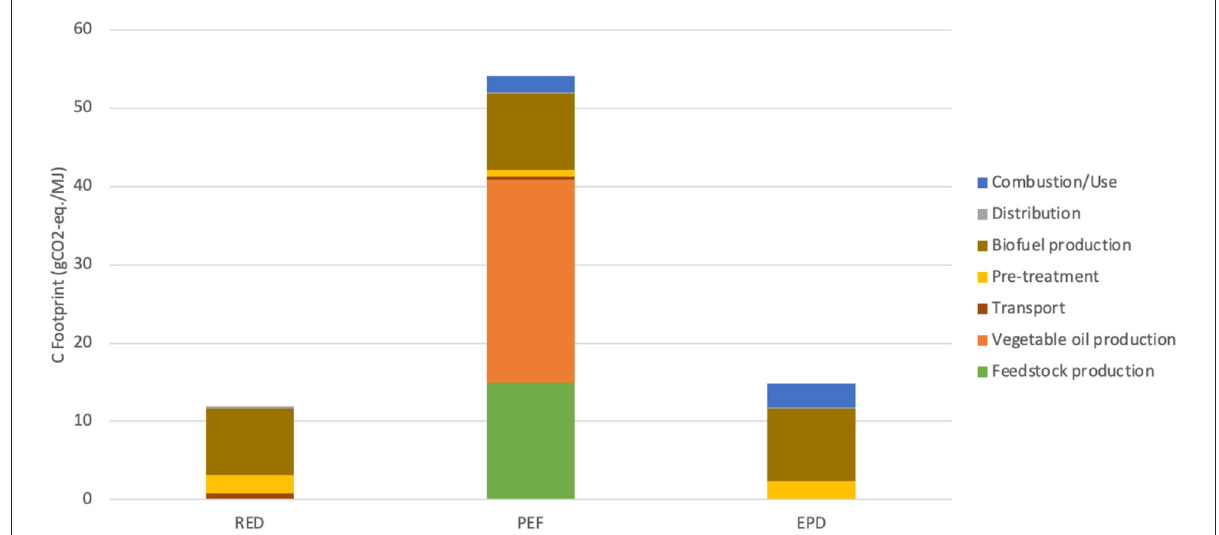
FIGURE4 Carbon footprint of UCO HVO, as modeled by RED II, PEF, and EPD. The CFF results includes part of the climate impact of virgin oil production.